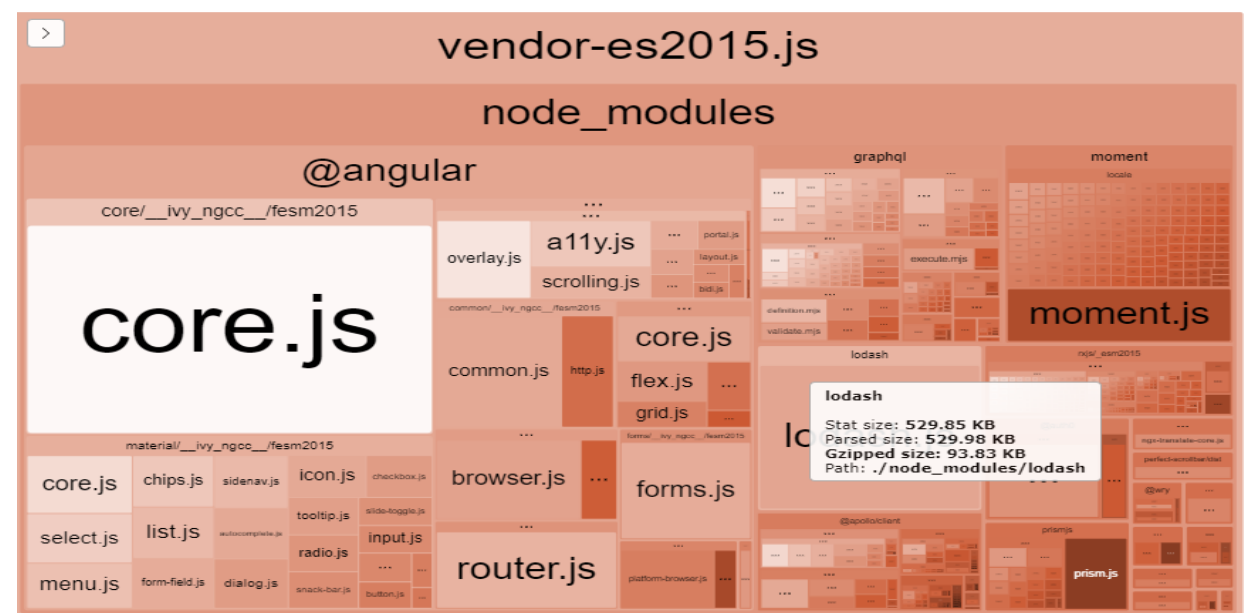
Figure 4. Image parsed by vendor.js file package.